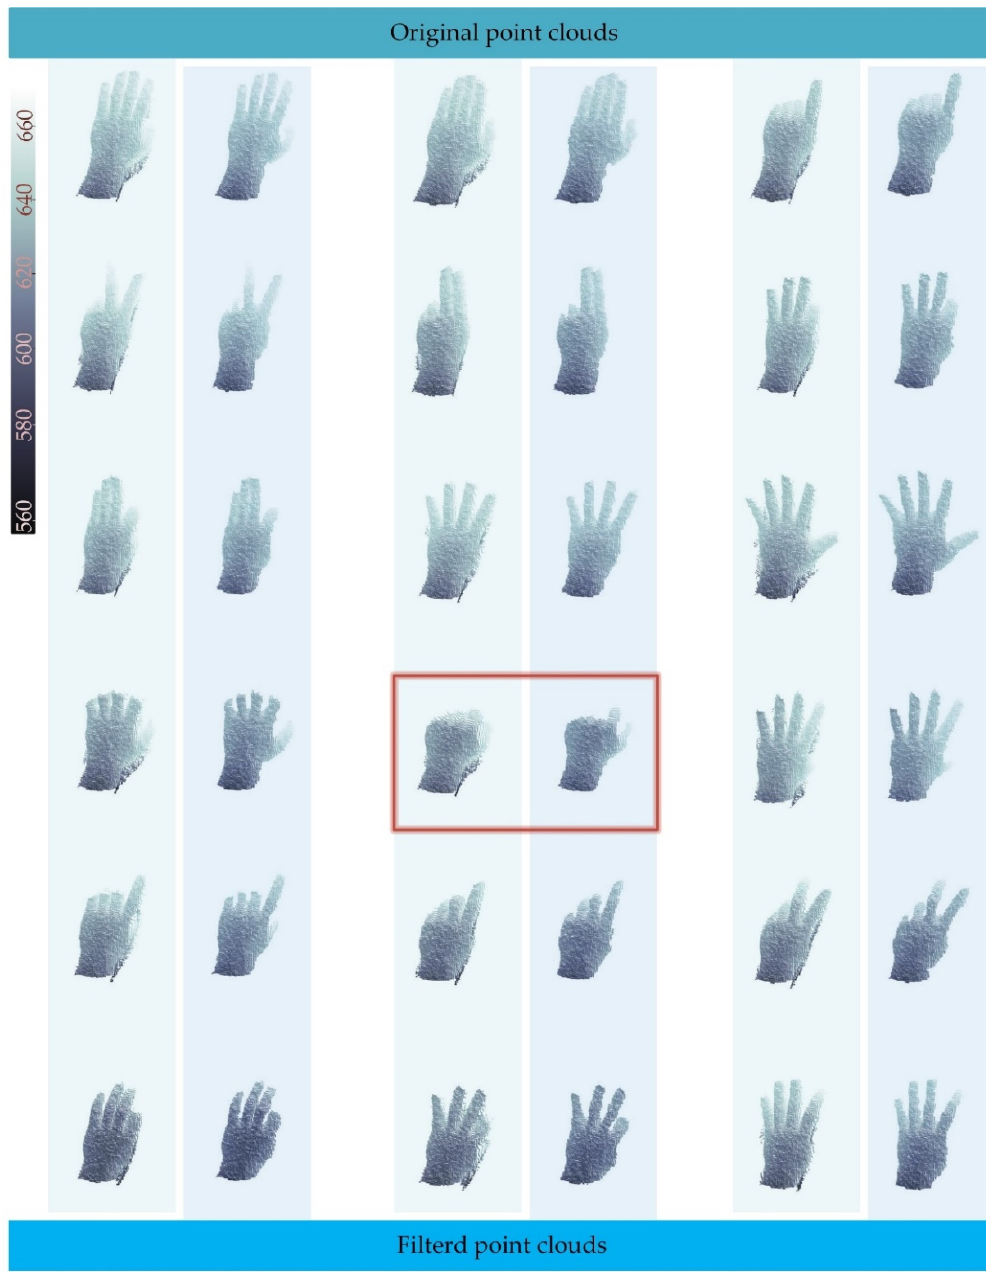
Figure 12. Comparisons of different hand gestures.